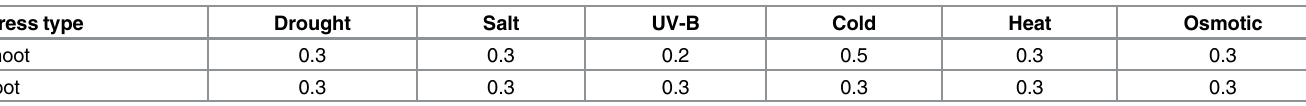
Table 2. The Selection of Parameter λ . Stress type